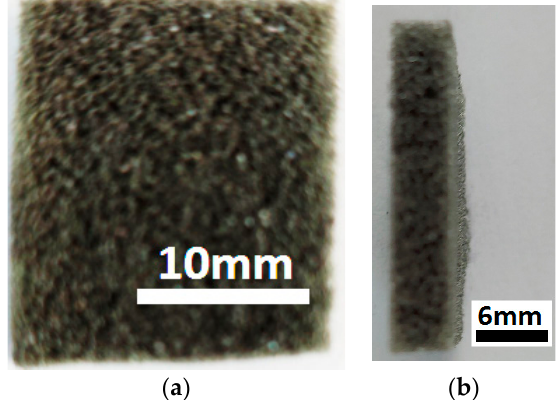
Figure 5. MPS photos: ( a ) Front view; ( b ) side view.